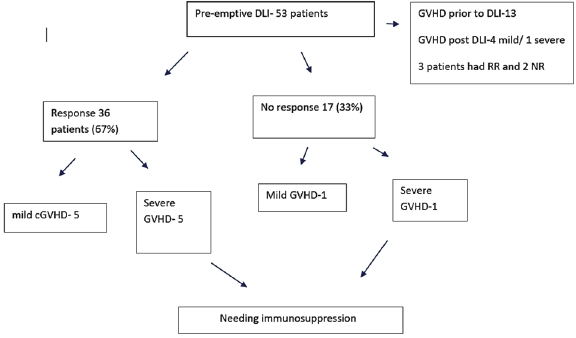
Fig. 4 Graphical representation of patients who got GVHD after